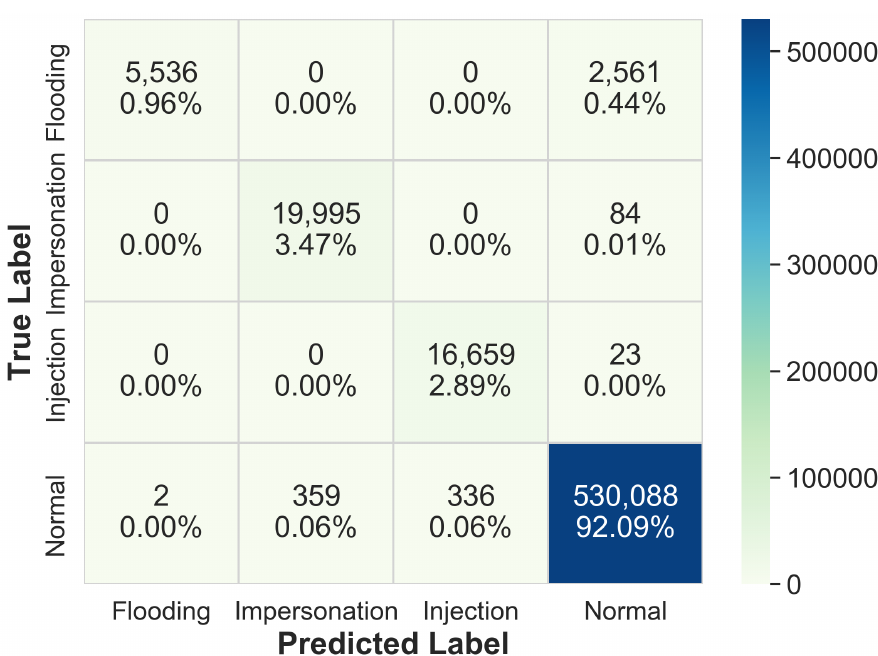
Figure 4. Confusion matrix of the second stage ML model.